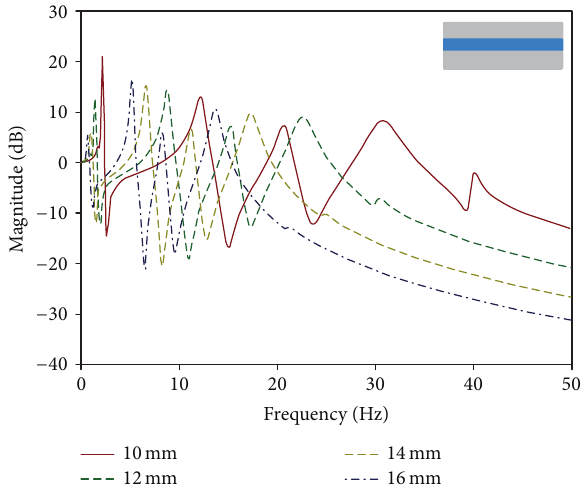
Figure8:Frequencyresponseofcylindricalaluminumpanelincase of SSDL with variety of lengths 𝑎 ( 𝜙 = 0.01 rad, 𝑅 = 20 m, 𝑡 1 = = 2 mm, 𝑡 = 5 mm, and 𝜂 = 0.1 ). 5 mm, 𝑡 2 3